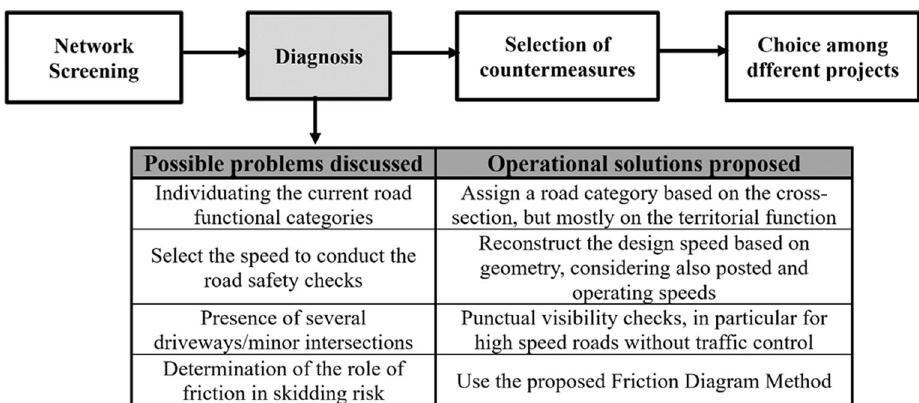
Fig. 5 Diagnosis stage. Problems